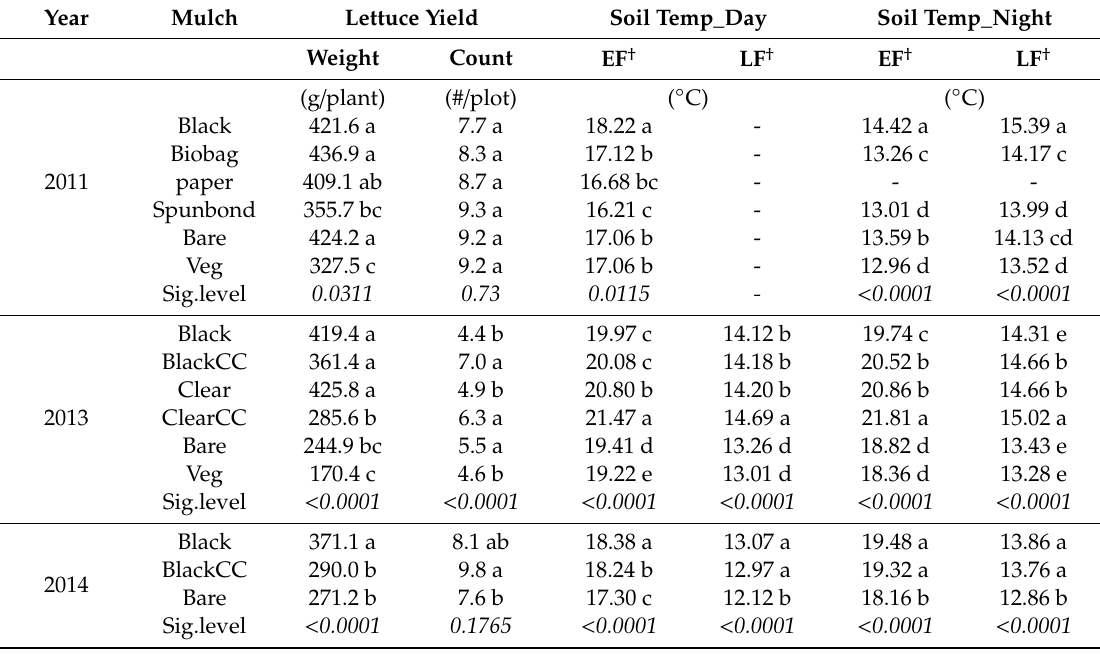
Figure 3. Marketable lettuce weight per plant and lettuce numbers per plot under the effects of different mulch over the falls of the years 2011 ( a ), 2013 ( b ), and 2014 ( c ) in HTs. Values followed by the same letter are not significant different according to Fisher’s LSD ( p = 0.1). Table 2. Marketable lettuce weight per plant and lettuce numbers per plot, and average soil temperatures at 10 cm depth under different mulch treatments during the day and night in the early and late falls of 2011, 2013, and 2014.